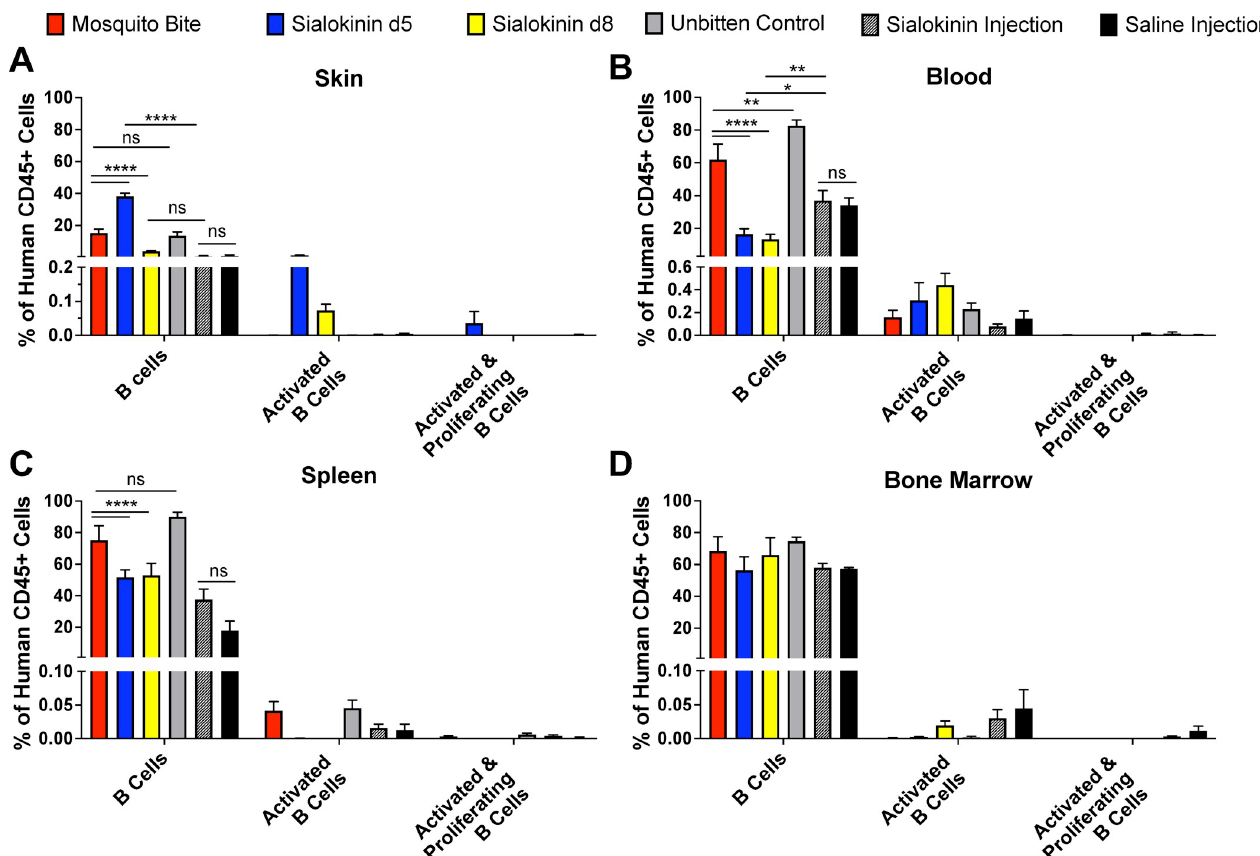
Fig 3. Sialokinin knockout mosquito bites influence B cell populations in humanized mice. Hu-NSG mice were subjected to four bites each from sialokinin knockout mosquitoes and were euthanized 7 days postbite. Skin ( A ), blood ( B ), spleen ( C ), and bone marrow ( D ) were collected and changes in B cell populations were assessed via flow cytometry. Mosquito Bite indicates mice bitten by wild-type mosquitoes, and Unbitten indicates mice that were not bitten by mosquitoes. Data are represented as the mean percentage of the cell population out of total human CD45+ cells. Error bars represent 1 SEM. Statistical significance was determined using two-way ANOVA followed by multiple comparison t-tests using the Holm-Sidak correction. The threshold for significance was p < 0.05. Asterisks indicate: � = p < 0.05; �� = p < 0.01; ���� = p < 0.001. Cell markers used to describe populations: B cells: CD45+, CD3-, CD19+; Activated B cells: CD3-, CD19+, CD80+, CD86+; Activated and proliferating B cells: CD3-, CD19+, CD80+, CD86+, Ki67+. Abbreviations: ns = not